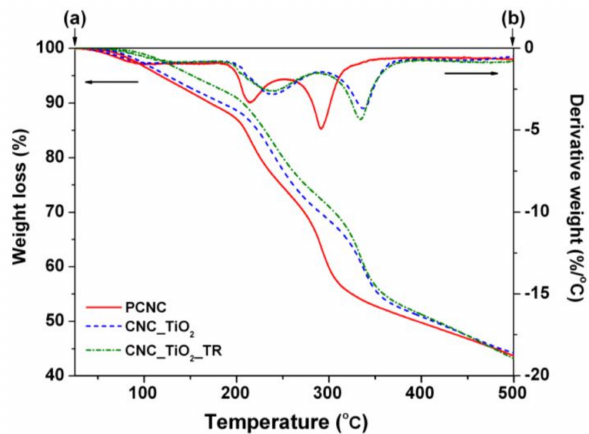
Figure 5. TGA (a) and DTG (b) curves of the obtained